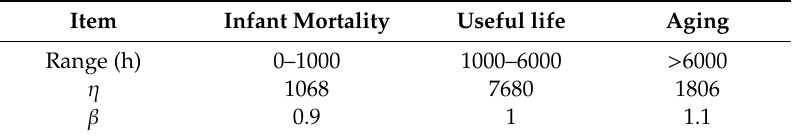
Figure 2. Initial and Corrected Health Index behavior. Table 9. Weibull parameters of the